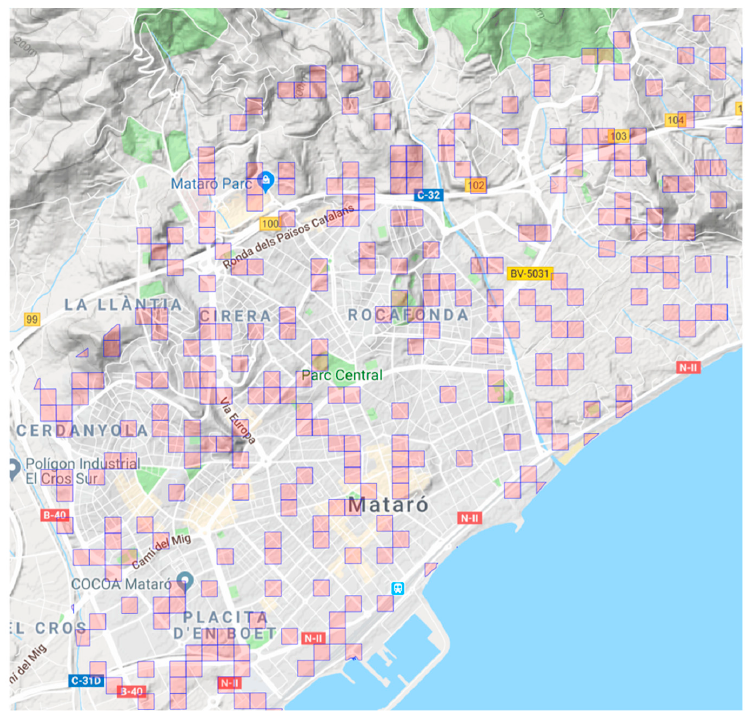
Figure 3. Randomly selected grids (100 m × 100 m) drawn over the Mataró map with the sampled street audits marked in magenta.